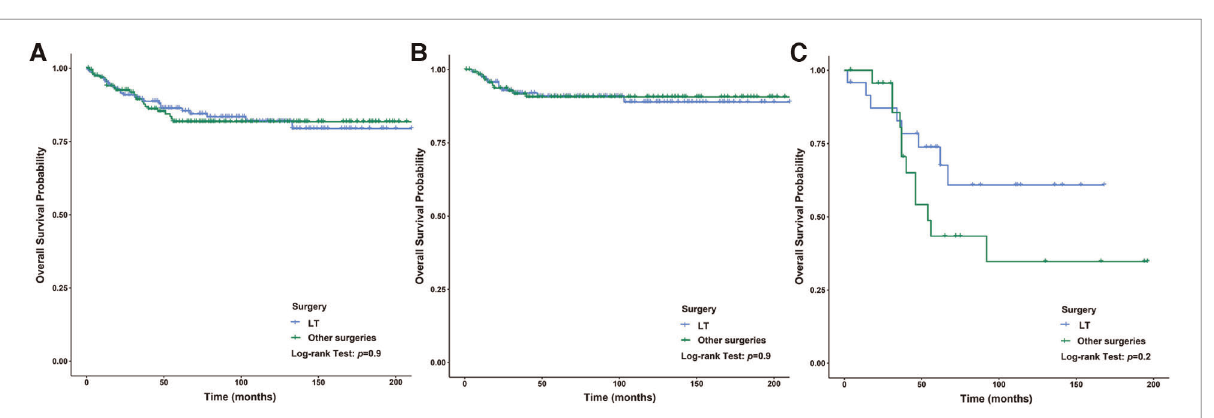
FIGURE 8 Survival curves of children with liver cancer between the LT group and the other surgeries group. ( A ) Survival curves of children with liver cancer after PSM between different therapy groups. ( B ) Survival curves of children with HB after PSM between different therapy groups. ( C ): Survival curves of children with HCC after PSM between different therapy groups. LT, Liver transplantation; HB, hepatoblastoma; HCC, hepatocellular carcinoma; PSM, propensity score